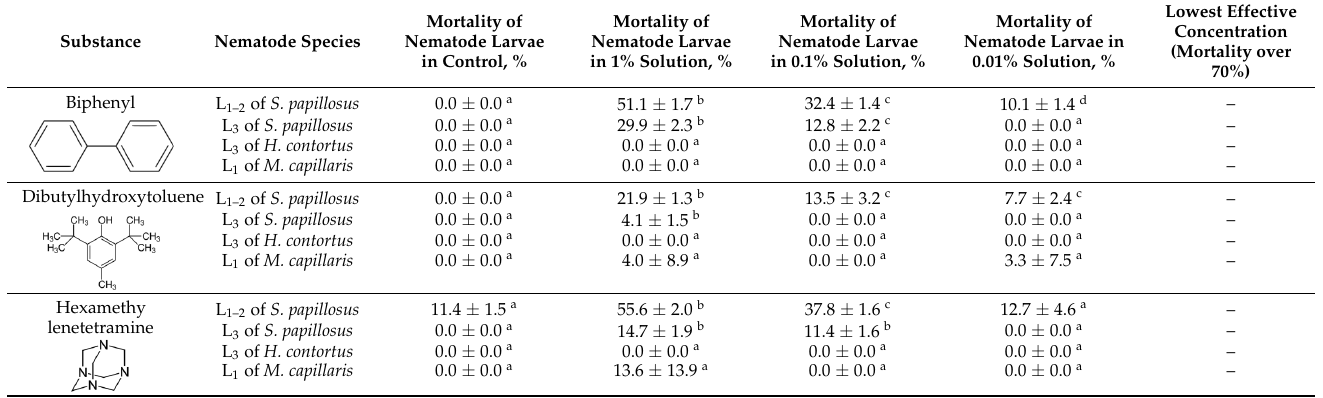
Table 5. Mortality of larvae of S. papillosus , H. contortus , and M. capillaris (%) during 24 h laboratory experiment under the influence of salts of organic food additives of various groups (x ± SD, n = 5). Mortality of Lowest Effective Nematode Substance Nematode Concentration Species Larvae in Larvae in 1% Larvae in 0.1% Larvae in 0.01% (Mortality over Control, % Solution, % Solution, % Solution, % 70%)